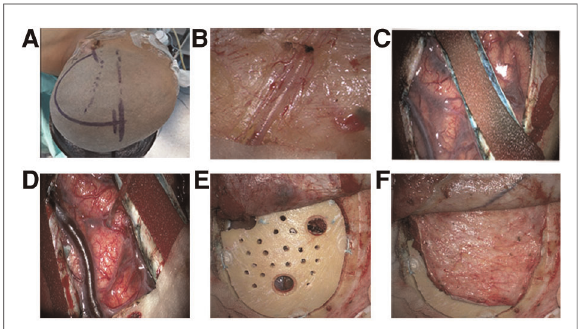
FIGURE 1 Surgical procedures. ( A ) Position and incisiona fronto-temporal- parietal approach was adopted, and the frontal branch of the (super fi cial temporal artery) STA was preserved. ( B ) The parietal branches of the STA was clearly visible on the medial surface of the fl ap and was carefully dissected from the fl ap as a donor vessel. ( C ) After the bone window was performed, the (middle meningeal artery) MMA trunk was preserved intact and incised on both sides. Then the remaining part of the dura mater was then opened radially, the margins inverted and tucked below the margins of the craniotomy. ( D ) The parietal branch of the separated STA was anastomosed to a recipient vessel (M4 segment of middle cerebral artery). ( E ) The free bone fl ap with multiple holes was returned to the anatomical position. ( F ) The temporal muscle fl ap was used to cover bone fl